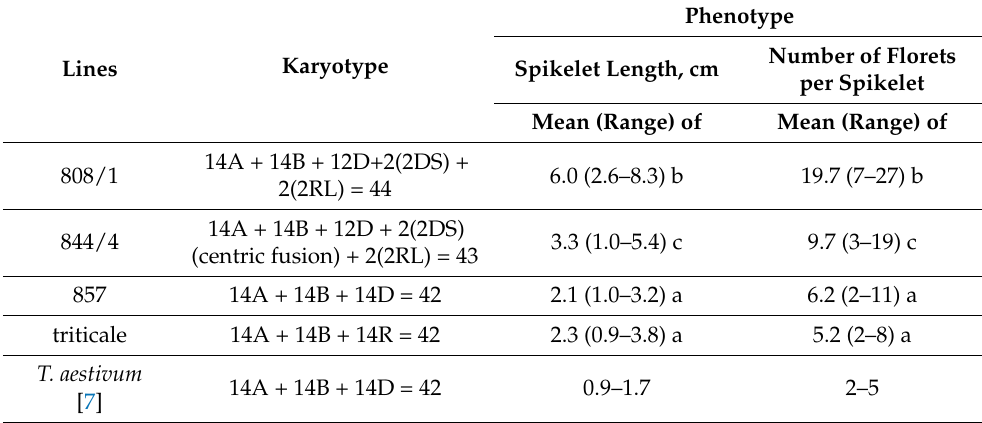
Table 2. Comparison data of triticale–wheat hybrid line karyotypes and spike morphology.